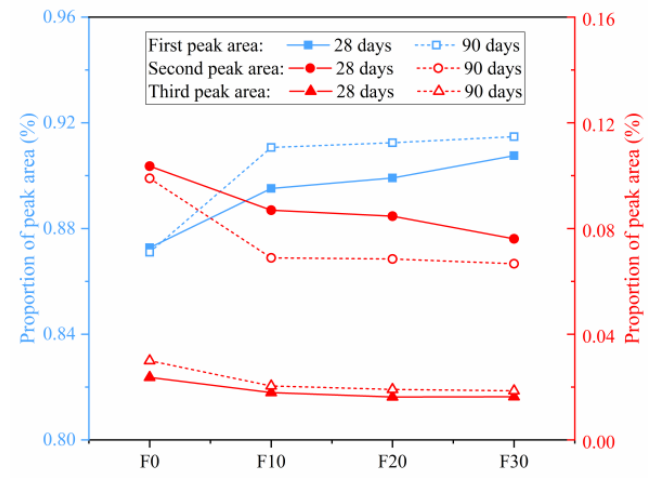
Figure 13. The proportion of each peak.